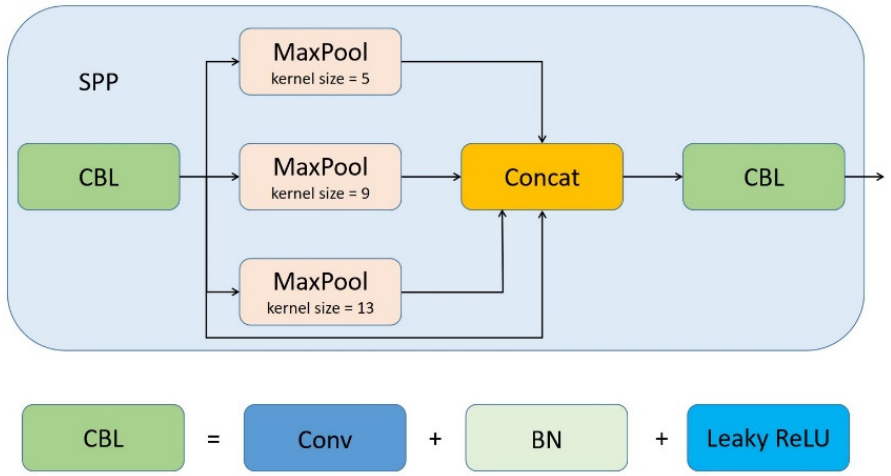
Figure 6. The architecture of SPP block in our improved TPH-YOLOv5. Generally, the features of shallow layers in the network have strong location information and are suitable for localization tasks; the features of deep layers in the networks have more advanced semantic information and are beneficial for classification tasks. FPN [25] combines positional and semantic information through the fusion of shallow and deep features, and predicts on different feature scales, so as to improve the detection performance. FPN has only top-down feature fusion, to which PANet [26] adds a bottom-up fusion path that more effectively utilizes the features extracted by the backbone. BiFPN [24] is a further improvement of the above path aggregation networks, which adds residual connections, removes edges with single input nodes to reduce the computational effort and uses a weighting mechanism for each scale feature to be fused to adjust the contribution of each scale. The structures of FPN, PANet and BiFPN are shown in Figure 7. By replacing PANet with BiFPN in TPH-YOLOv5, a better trade-off between accuracy and efficiency can be achieved.